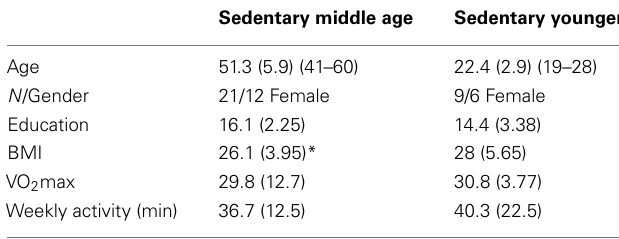
significance at *p < 0.05. Table 3 | Sedentary participant characteristics.